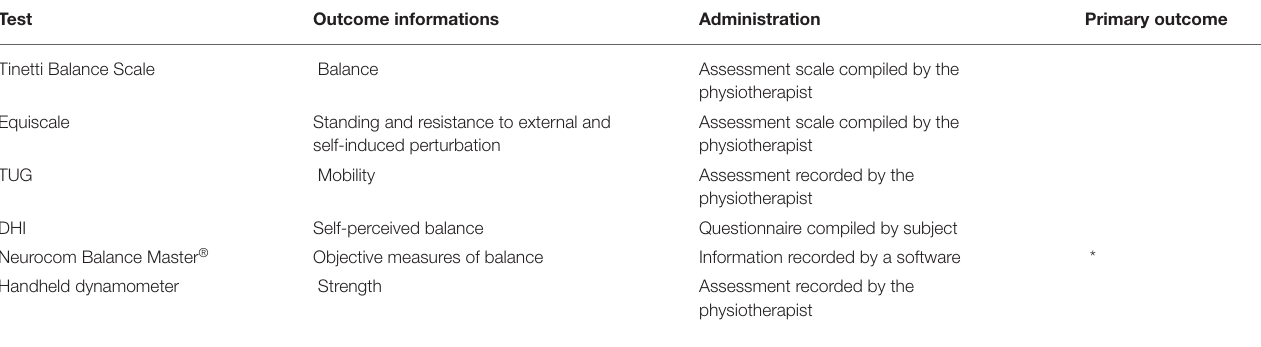
TABLE 1 | Outcome